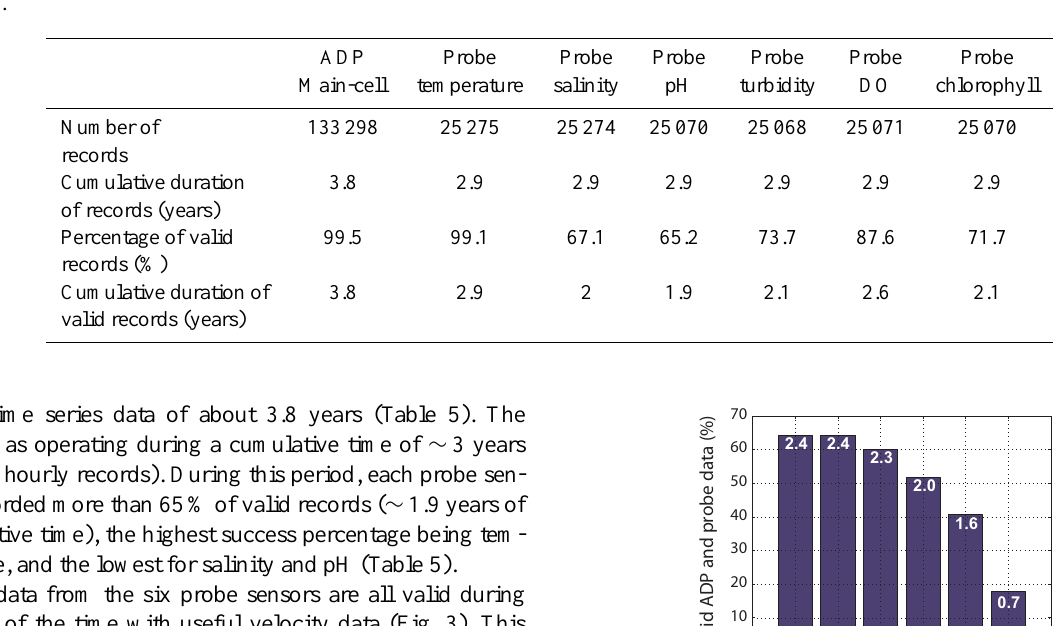
Table 5. Statistics of valid and accepted ADP and valid probe records. ADP statistics were computed based on the main-cell north veloc- ity component; similar results are obtained with the other (main-cell and multi-cell) velocity components. Ambiguous probe data are not included.